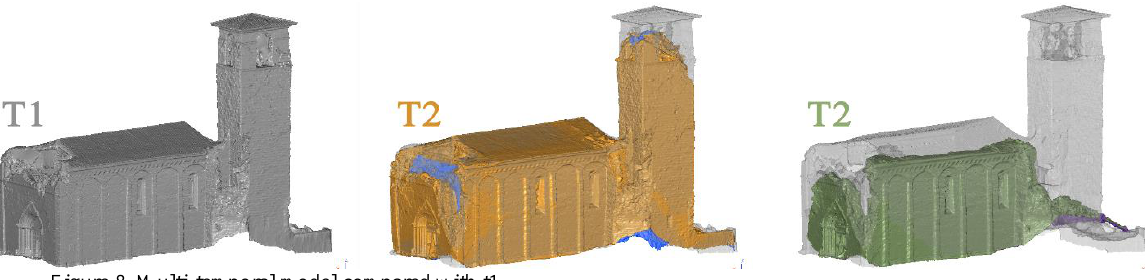
Figure 8. Multi-temporal model compared with t1